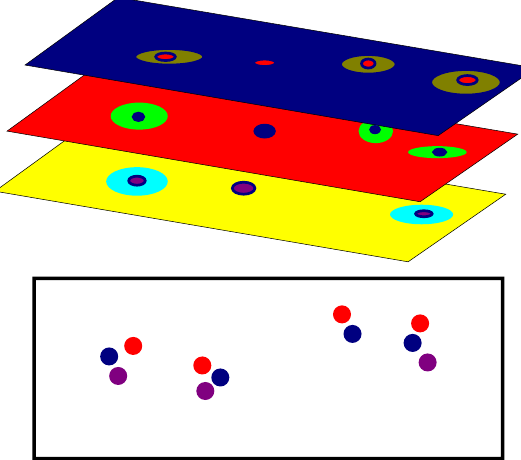
Figure 5. Projection uncertainty arisen from the fact that anthropometric planes are based on average measures in anthropometric planes and actual person’s height, 2) Although neck and head are on the same line splitting the body into half, left and right shoulders are located on each side of this line. There- fore, even for joints locating exactly on an anthropometric plane, projections won’t coincide. 3) Detection results are not reliable.